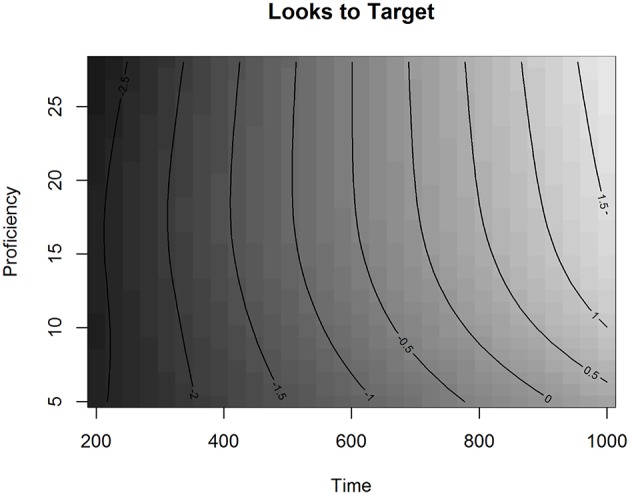
The effect of Proficiency over Time in Experiment 1 in the L2 group, fitted values.